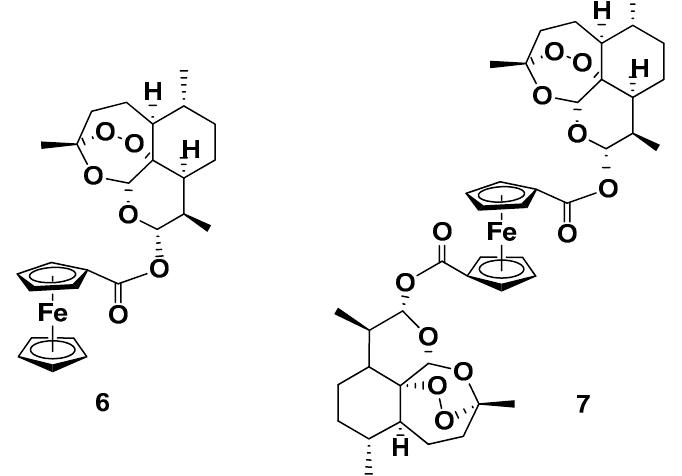
Figure 3. Mono- and di-artemisinin ferrocene derivatives.